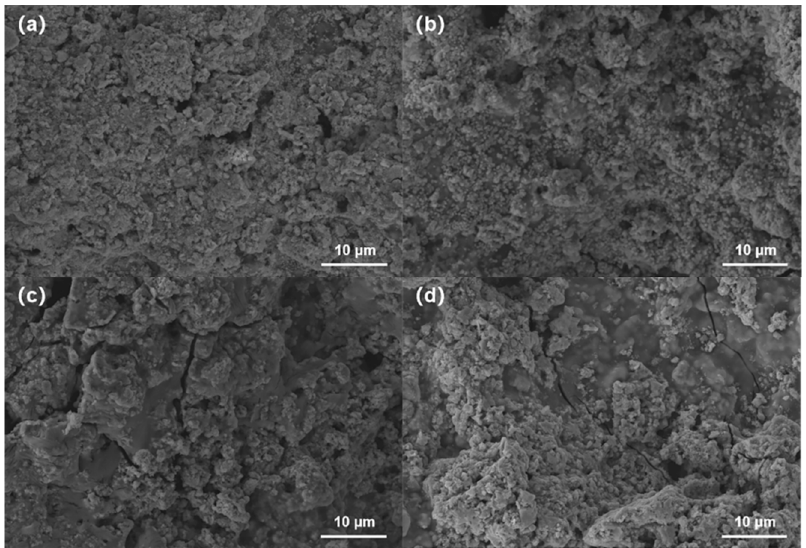
Figure 3. The SEM of ( a ) P1.1 film, ( b ) P1.2 film, ( c ) P1.3 film, ( d ) P1.4 film.